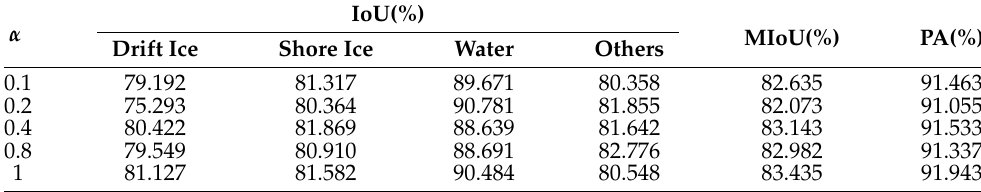
Table 3. The influence of different auxiliary loss functions weight α on the segmentation results.